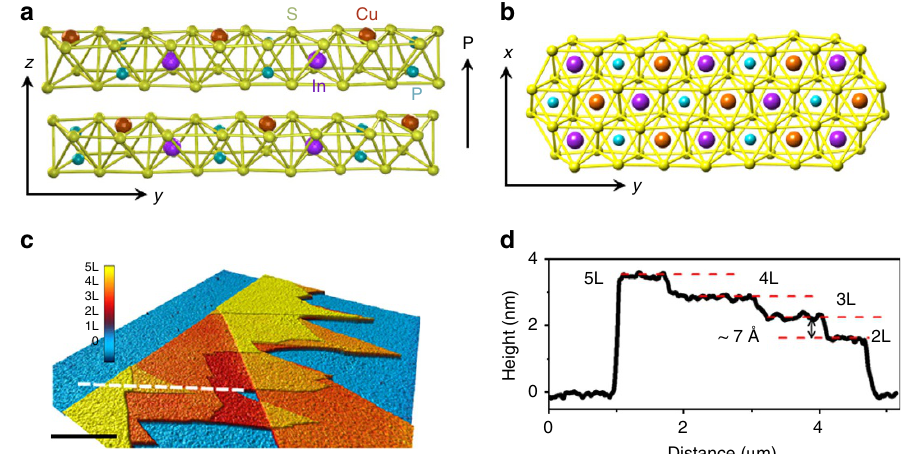
Figure 1 | Crystal structure and characterization of CIPS. ( a , b ) The side view ( a ) and side view ( b ) for the crystal structure of CIPS with vdWgap between the layers. Within a layer, the Cu, In and P–P form separate triangular networks. The polarization direction is indicated in by the arrow. ( b ) The ferroelectric hysteresis loop of a 4- m m-thick CIPS flake. ( c ) AFM image of the CIPS flakes with different thicknesses. Scale bar, 2 m m. ( d ) The height profile along the line shown in c . Clear step height of 0.7nm corresponding to single layer thickness of CIPS can be observed. L,